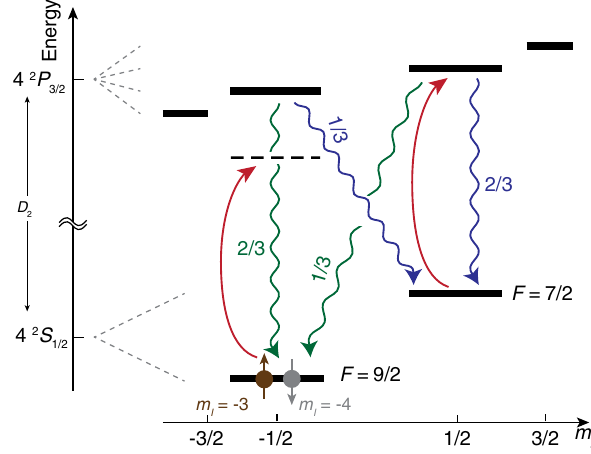
FIG. 5. Level scheme of 40 K: Schematics of the atomic hyperfine levels and transitions relevant to the scattering of photons. Levels are labeled using both their quantum number m j and their respective hyperfine manifold F . Here, F labels the manifold that the state is adiabatically connected to at low magnetic fields. The quantum number m is, to a good approxi- i mation, not coupled to optical transitions as the system is close to − 3 i and the Paschen-Back regime. The two spin states j m I ¼ j − 4 i adiabatically connect to the j m F ¼ − 7 = 2 i and j − 9 = 2 i states at low magnetic fields. The dedicated scattering light is shown as red arrows; spontaneous emission processes are indicated as wavy lines, along with their branching